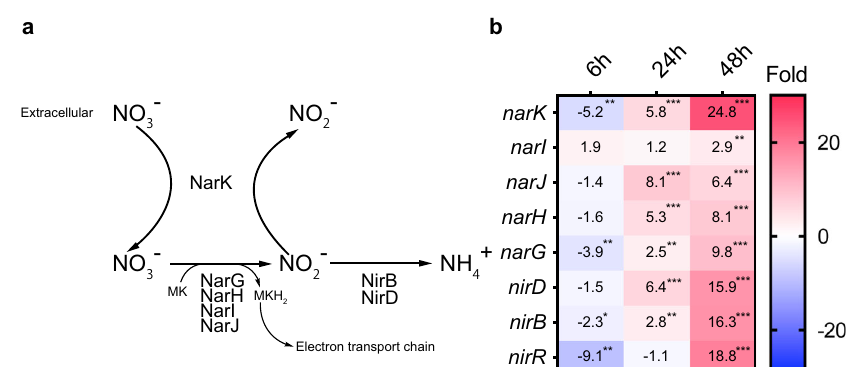
Fig. 3 Gene expression changes regarding nitrate respiration of S. aureus infected in liver. a Metabolic pathway of nitrate in S. aureus . b Expression changes in genes involved in the nitrogen respiration pathway. The values in the box show fold-change compared with S. aureus cultured in the TSB medium and the boxes. The asterisk *. **, and *** indicate FDR p -values < 0.05, <0.01, and <0.001, respectively.